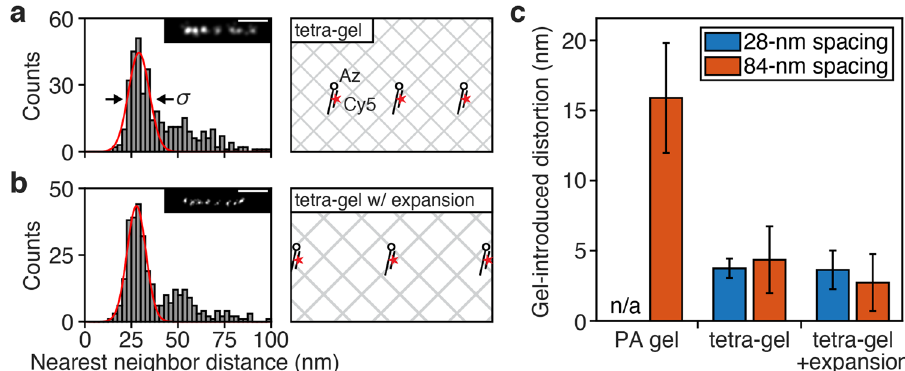
Figure 2. Tetra-gel embedding enables superior structural preservation at sub-10 nm scale. ( a , b ) STORM image analysis for linear origami with azides post-embedding in (a) non-expanding tetra-gel (N = 100 origami objects), and ( b ) expanding tetra-gel with 2.2X expansion (N = 83 origami objects). Insets show representative STORM images of single origami objects. The scale bars in the insets are 100 nm. Red curves show Gaussian fits of the first peaks, mean ± standard deviation: ( a ) 29.1 ± 8.0 nm and ( b ) 27.7 ± 7.2 nm; arrows indicate standard deviation σ . ( c ) Gel-introduced distortion in emitter position, calculated by comparing the standard deviations of individual emitter positions before and after denaturation in each gel (Extended Data Fig. 4). Bars and error bars show mean ± standard